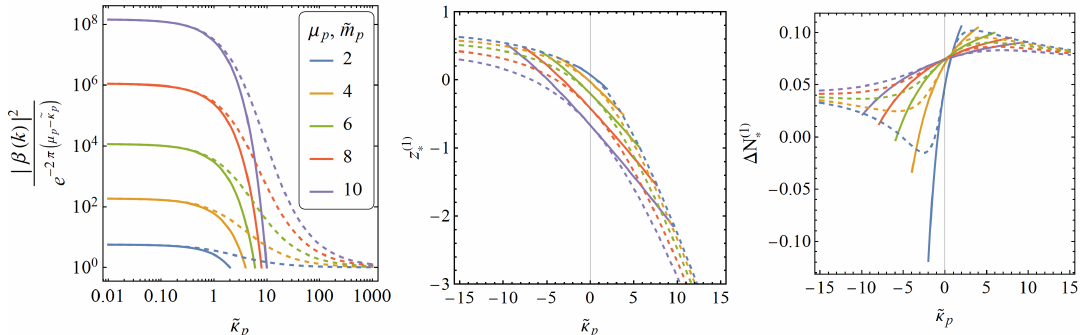
Figure 12 . The O ( (cid:15) ) corrections to production histories in deformed dS with (cid:15) = 0 . 1 . Left panel: production amount excluding zeroth-order contribution as a function of the dimensionless chemical potential for different particle masses. Middle panel: the correction to z -domain production time dependence on chemical potential and mass. Right panel: the correction to production width measured in e-folding numbers. In all three plots, solid lines represent spin-1 bosons while dashed lines represent spin-1/2 fermions. Particles with different masses are distinguished by the colors of the lines according to the legend in the left panel. For bosons, we limit the range of chemical potential to be smaller than the mass, so that no tachyonic instability is induced. For fermions, the chemical potential is not restricted and we allow it to take arbitrarily large